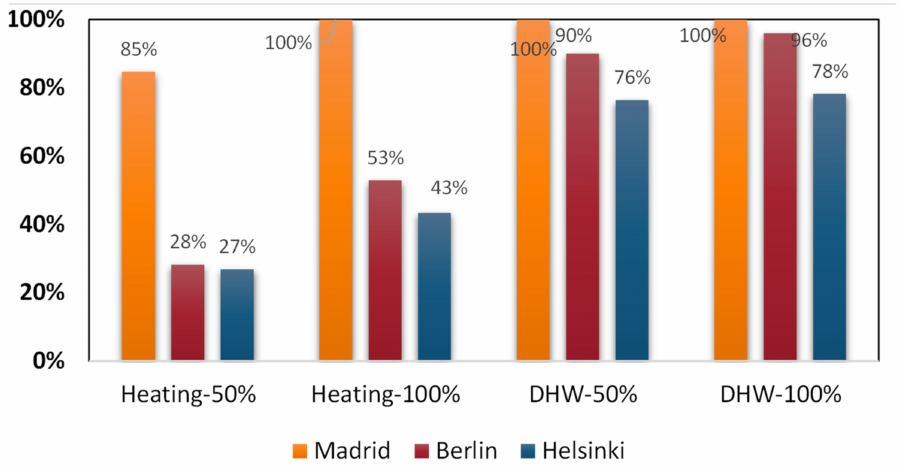
Figure 5. Solar fraction for heating and DHW in the different